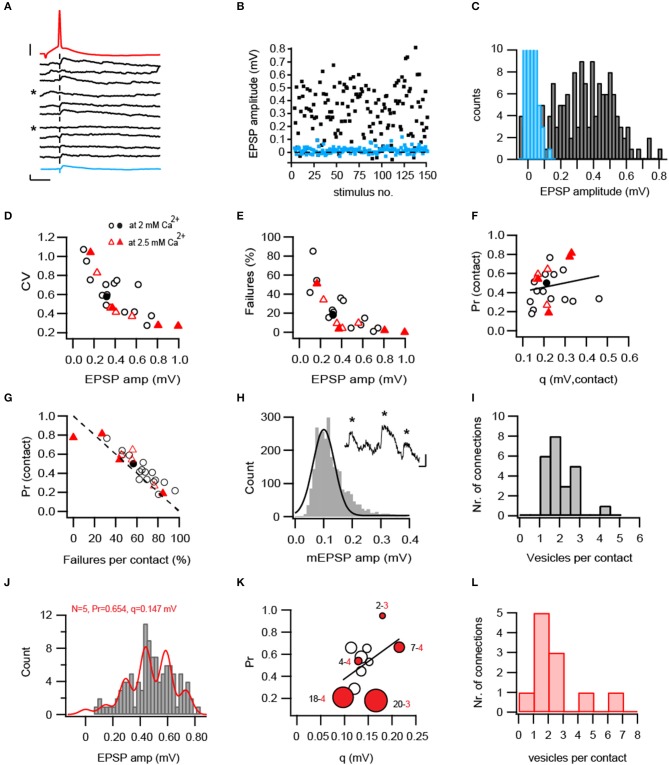
Functional properties of L5B-L5B pyramidal cell connections. (A) Consecutive EPSPs (black) in response to presynaptic APs (red) evoked at 0.125 Hz. The average EPSP of 30 trials is shown below as a thick blue trace. Failures to evoke an EPSP were denoted by asterisks. Scale bars: 1 and 20 mV for the EPSP and AP, respectively and 10 ms for both. (B) EPSPs (black squares) were stationary over 148 trials but fluctuated strongly in amplitude and failures (blue squares) were often observed (18%). (C) Broad distribution of EPSP amplitudes (black bars) showing the absence of clearly separated peaks in their histogram. Blue bars represent background noise, curtailed for better visibility. (D–E) CV of the EPSP amplitudes (D) and percentage failures (E) decrease in connections with larger EPSP amplitudes (n = 25). Filled symbols represent connections for which the number of synaptic contacts was determined from the 3D-reconstructions. (F) Absence of correlation between Pr and q at individual synaptic contacts (R = 0.19, R2 = 0.036, P = 0.39). Note that contacts with large q have either a low or high Pr. (G)
Pr (calculated from the CV) is strongly anti-correlated with the independently-measured percentage failures per contact (R = −0.824, R2 = 0.67, P < 10−5). The unity line is shown in a dashed stroke. (H) The vesicular quantal size estimated from measurements of spontaneous fast mEPSPs impinging onto L5B neurons (examples in inset are denoted by asterisks). A Gaussian function was fitted with a median of 0.113 mV and SD = 0.053 (n = 2803 events from 7 neurons). (I) Estimates of synchronous vesicular release. Between 1 to 4 vesicles are released from individual contacts during a single AP. (J–L) Binomial quantal parameters obtained from model fitting to the EPSP amplitude histogram. (J) Example of a successful fit (red line) depicting distinctive peaks in the EPSP amplitude histogram. (K) Model estimates from 11 successfully-fitted connections. Pr and q are displayed in the Y- and X-axis, respectively. Estimated N is displayed as a function of marker size (small-to-large). Red-filled circles mark the anatomically reconstructed connections. The numbers next to them denote the model-estimated number of release sites (black) and anatomically determined number of contacts (red). Linear correlation between Pr and q was non-significant (R2 = 0.209, P = 16). (L) Estimates of number of vesicles released per contact based on the quantal binomial fits. The model-estimated N was divided by the averaged (4) or connection-specific number of anatomically identified contacts.